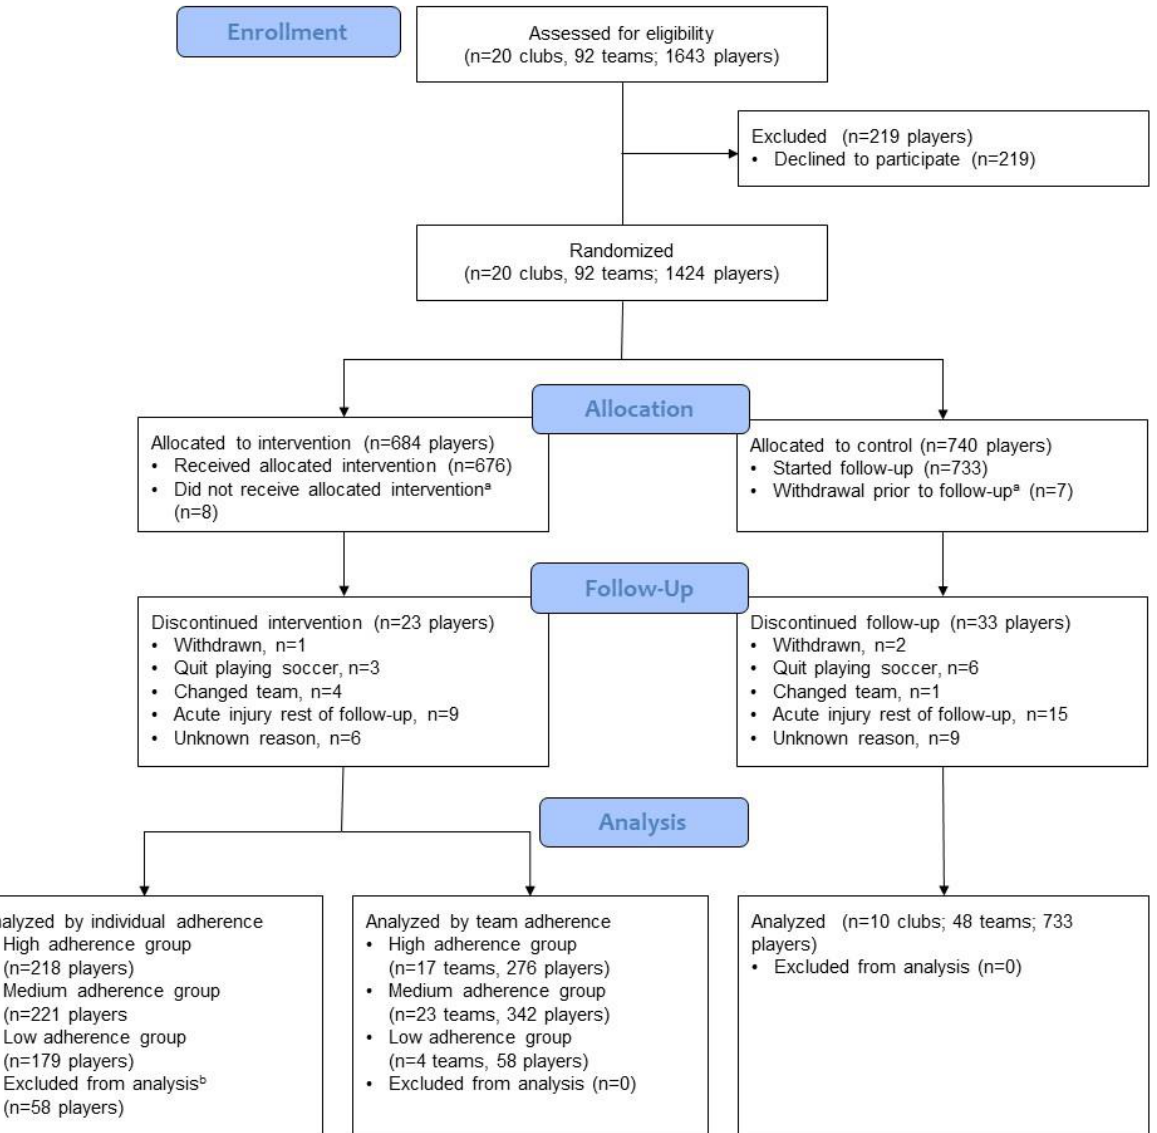
Figure 1. CONSORT Flow Chart. a Stopped playing in the participating teams prior to follow-up. b Missing individual adherence data.